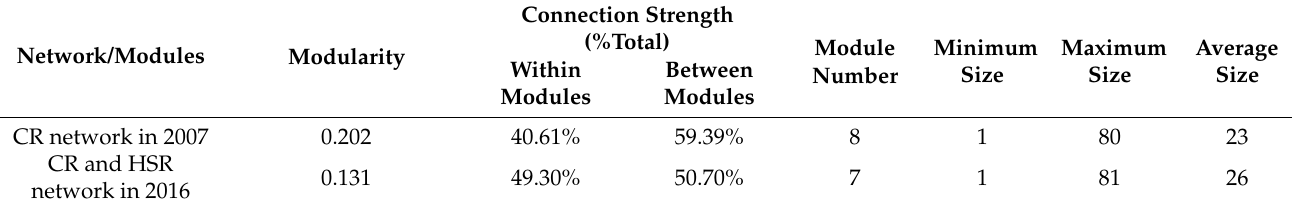
Figure 5. Modular structures of economic networks before HSR in 2007 and after HSR in 2016 (different colors represent different modules; the number in the brackets denotes the number of cities in this community). Table 4. Network community detection in railway networks before and after